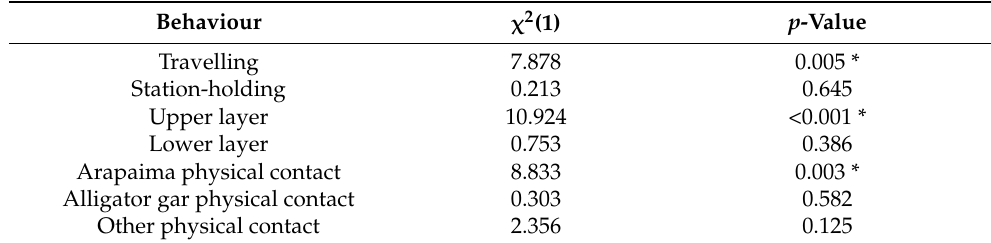
Table 5. Results of observed frequency likelihood ratio test comparing the two linear mixed models, one with and the other without the fixed effect (effect of the use of the green laser pointer).